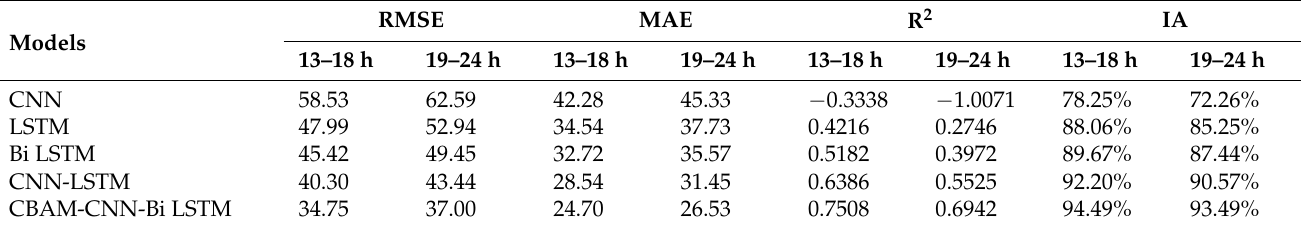
Table 6. Performance evaluation indicators for model prediction (h13–h24).